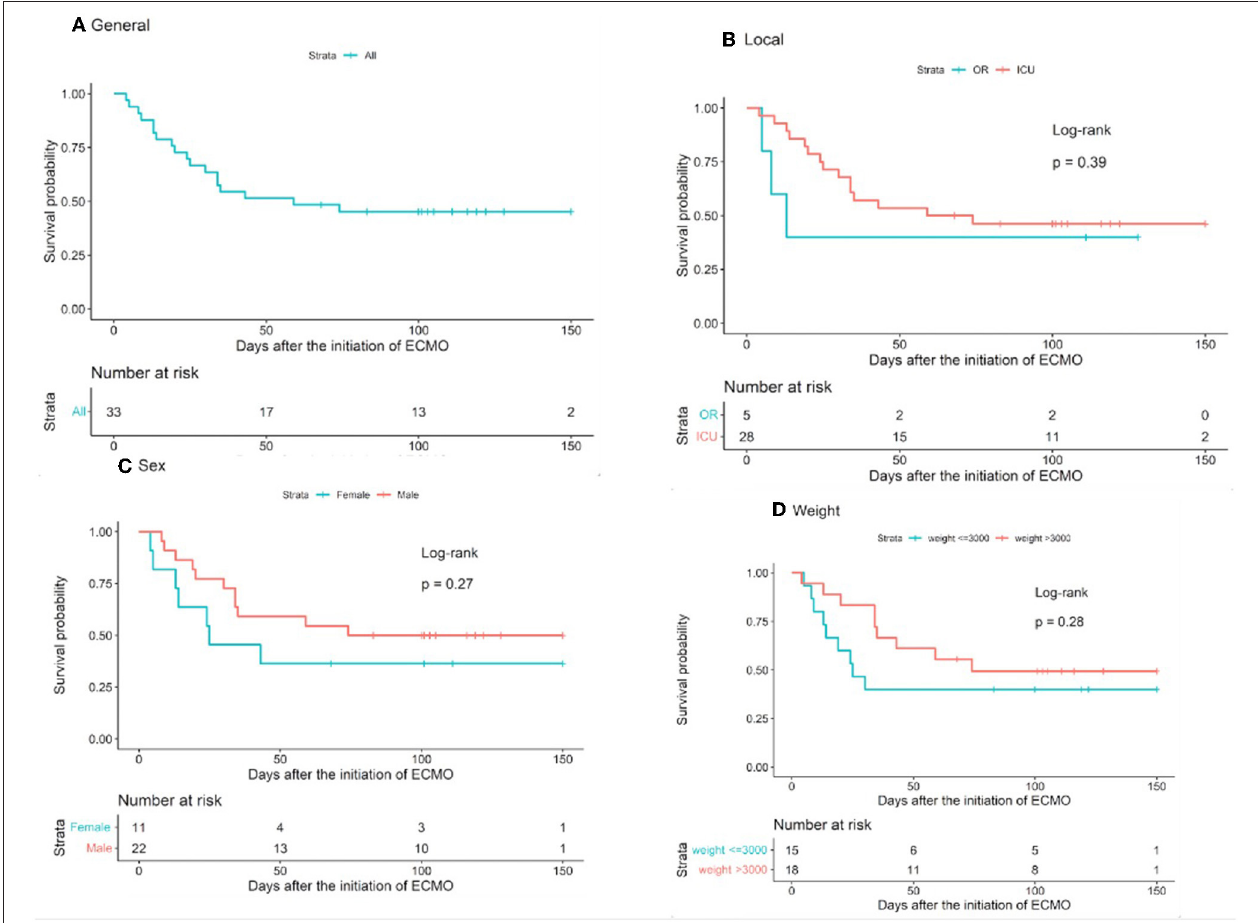
FIGURE 3 | Survival curves. (A) General and according to (B) location of ECMO initiation, (C) patient sex, and (D) patient weight. Error bars indicate standard error of